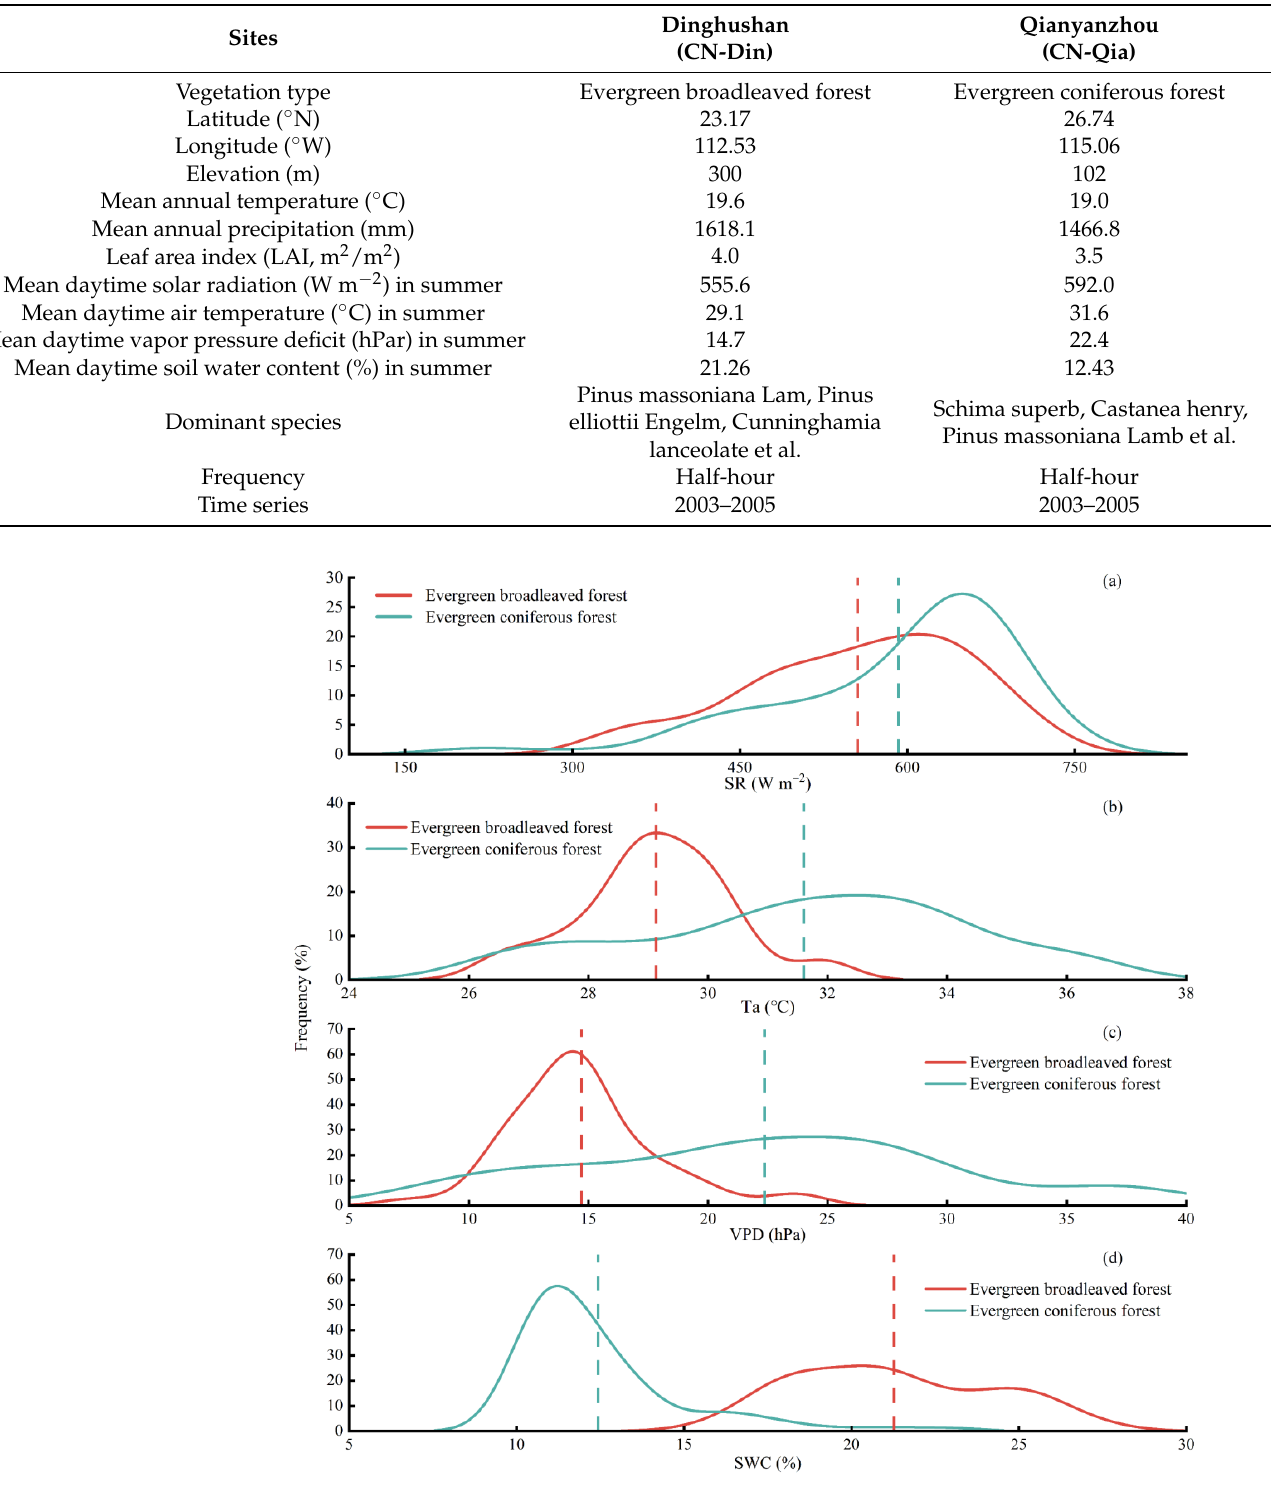
Figure 1. The frequency of summer daytime shortwave radiation (SR, ( a )), air temperature (Ta, ( b )), vapor pressure deficit (VPD, ( c )), and soil water content (SWC, ( d )) in the Dinghushan evergreen broadleaved forest (red solid line) and Qianyanzhou evergreen coniferous forest (cyan solid line). The dashed lines show the mean value of the meteorological variables at Dinghushan (red dashed line) and Qianyanzhou (cyan dashed line) during summer daytime; the specific values are presented in Table 1.